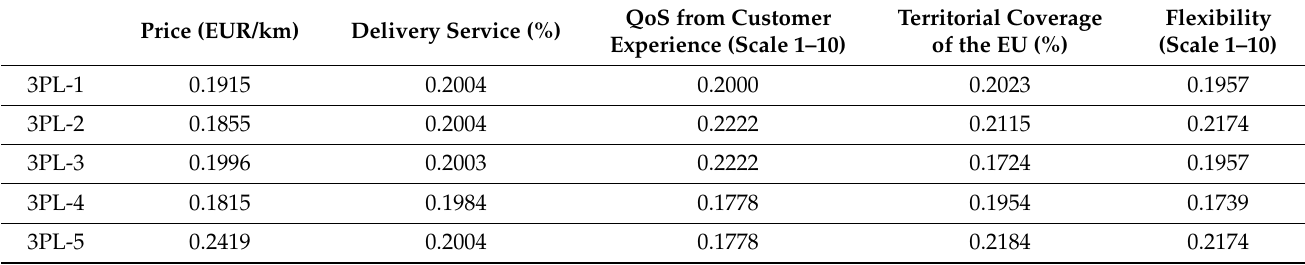
Table 4. Normalization of the entropy decision-making matrix (Source: